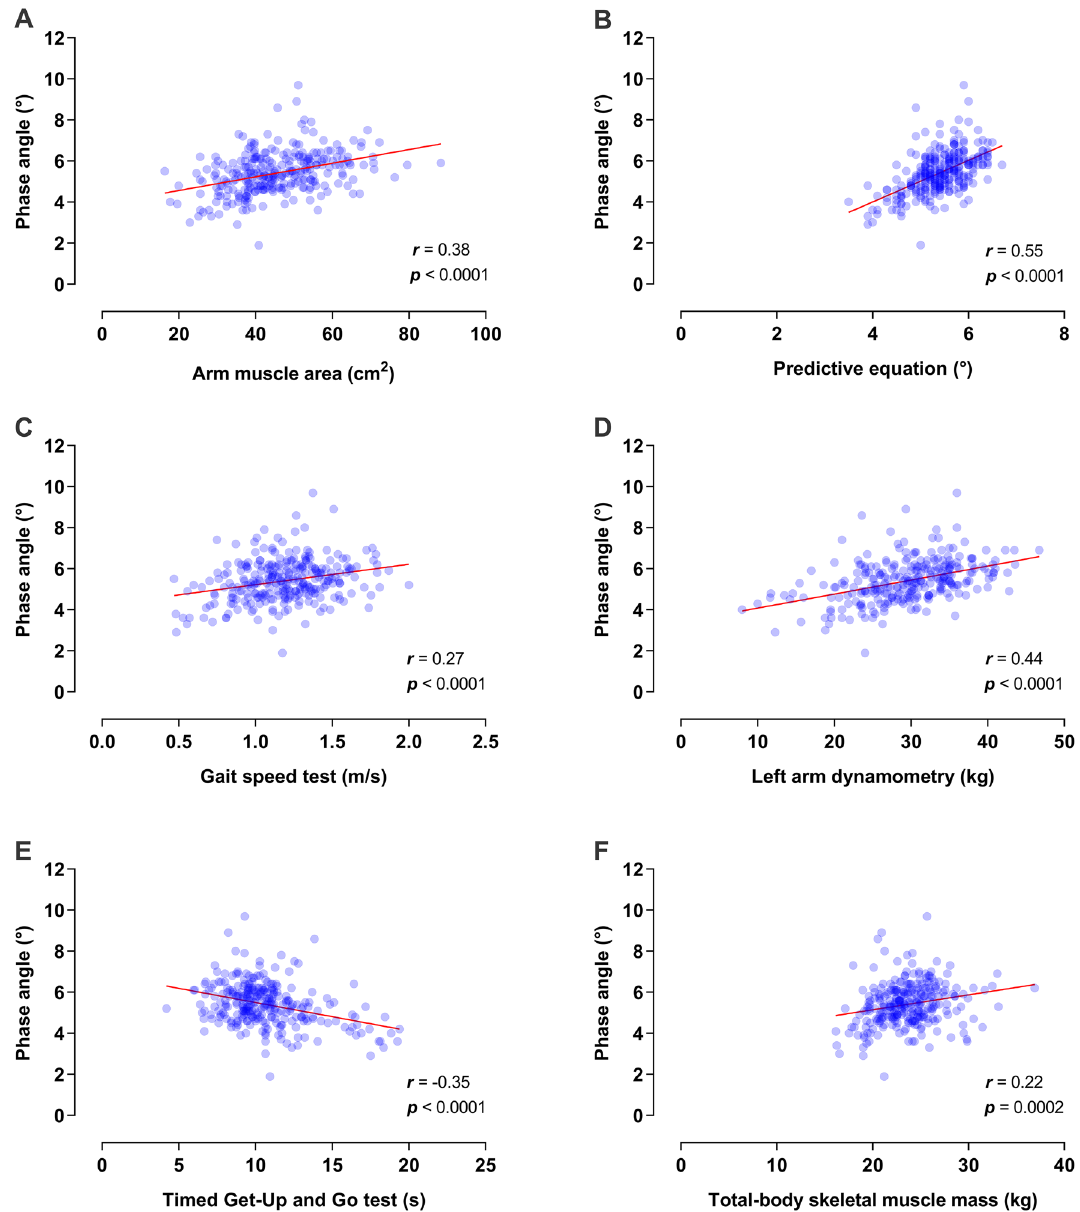
Figure 2. Relationship between alternative tests and BIVA for muscle wasting assessment among subjects with prostate cancer. (A) Scatter plot and Pearson correlation between arm muscle area (cm 2 ) and phase angle. (B) Scatter plot and Pearson correlation between the predicted value through the equation for phase angle (°) and observed phase angle (°). (C) Scatter plot and Pearson correlation between Gait speed test (m/s) performance and phase angle. (D) Scatter plot and Pearson correlation between Handgrip left arm dynamometry (kg) and phase angle. (E) Scatter plot and Pearson correlation between Timed Get-Up and Go test performance (s) and phase angle. (F) Scatter plot and Pearson correlation between Total-body skeletal muscle mass (kg) and phase